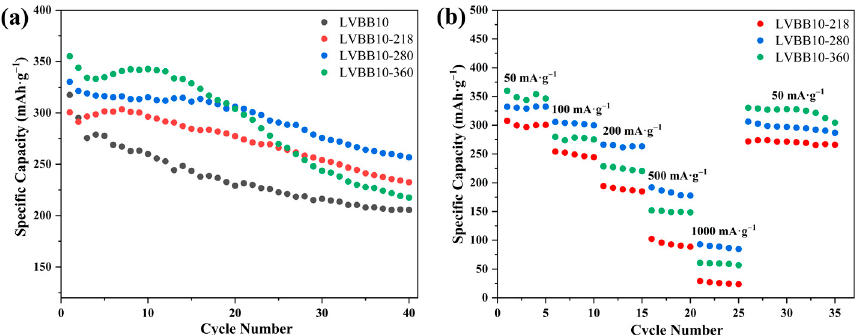
Figure 8. ( a ) Cycling data showing the initial 40 cycles (at 50 mA·g − 1 , in the voltage range of 1.5–4.2 V) of LVBB10, LVBB10-218, LVBB10-280 and LVBB10-360; ( b ) rate capability tests (at different rates from 50 to 1000 mA·g − 1 ) of LVBB10-218, LVBB10-280 and LVBB10-360 samples.